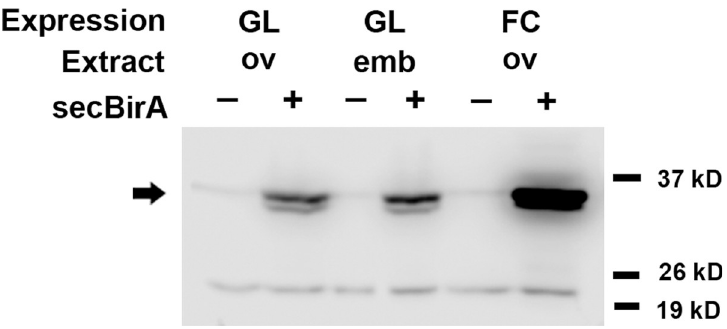
Fig 1. Gal4-mediated expression of secBirA protein in Drosophila ovaries and embryos. Protein homogenates were prepared from ovaries (GL ov) and progeny embryos (GL emb) from females expressing secBirA(+) in the female germline (nurse cells) under the control of the Nanos-Gal4 :: VP16 driver element [61] and from homogenates isolated from the ovaries of females expressing secBirA(+) in the follicle cell layer (FC ov) under the control of the CY2-Gal4 driver element [62]. These were subjected to Western blot analysis using an antibody directed against full-length BirA protein. Control homogenates were from ovaries and embryos carrying the corresponding Gal4 driver elements in the absence of the secBirA expression construct (-). Note the presence of a pair of specific bands (indicated by the arrow) in homogenates from tissues expressing secBirA, whose molecular masses correspond closely with the predicted molecular weights of full-length secBirA and of secBirA from which the signal peptide has been cleaved.